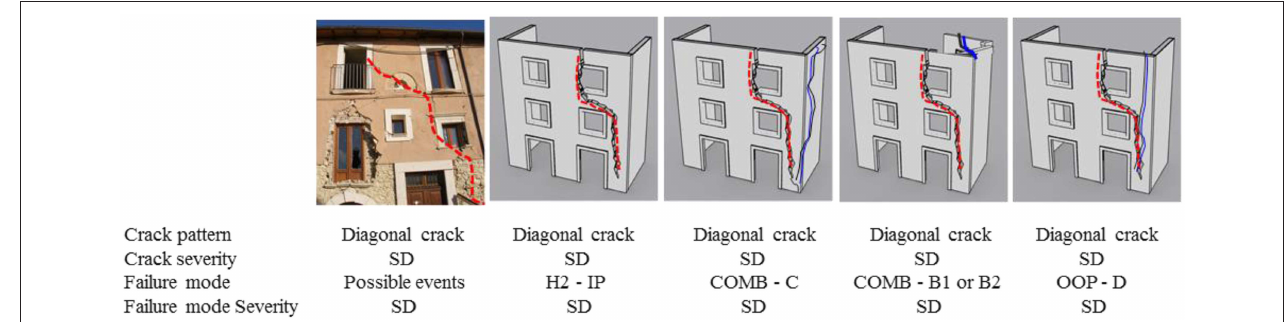
FIGURE 5 | POSSIBLE failure modes that can be associated to an observed crack